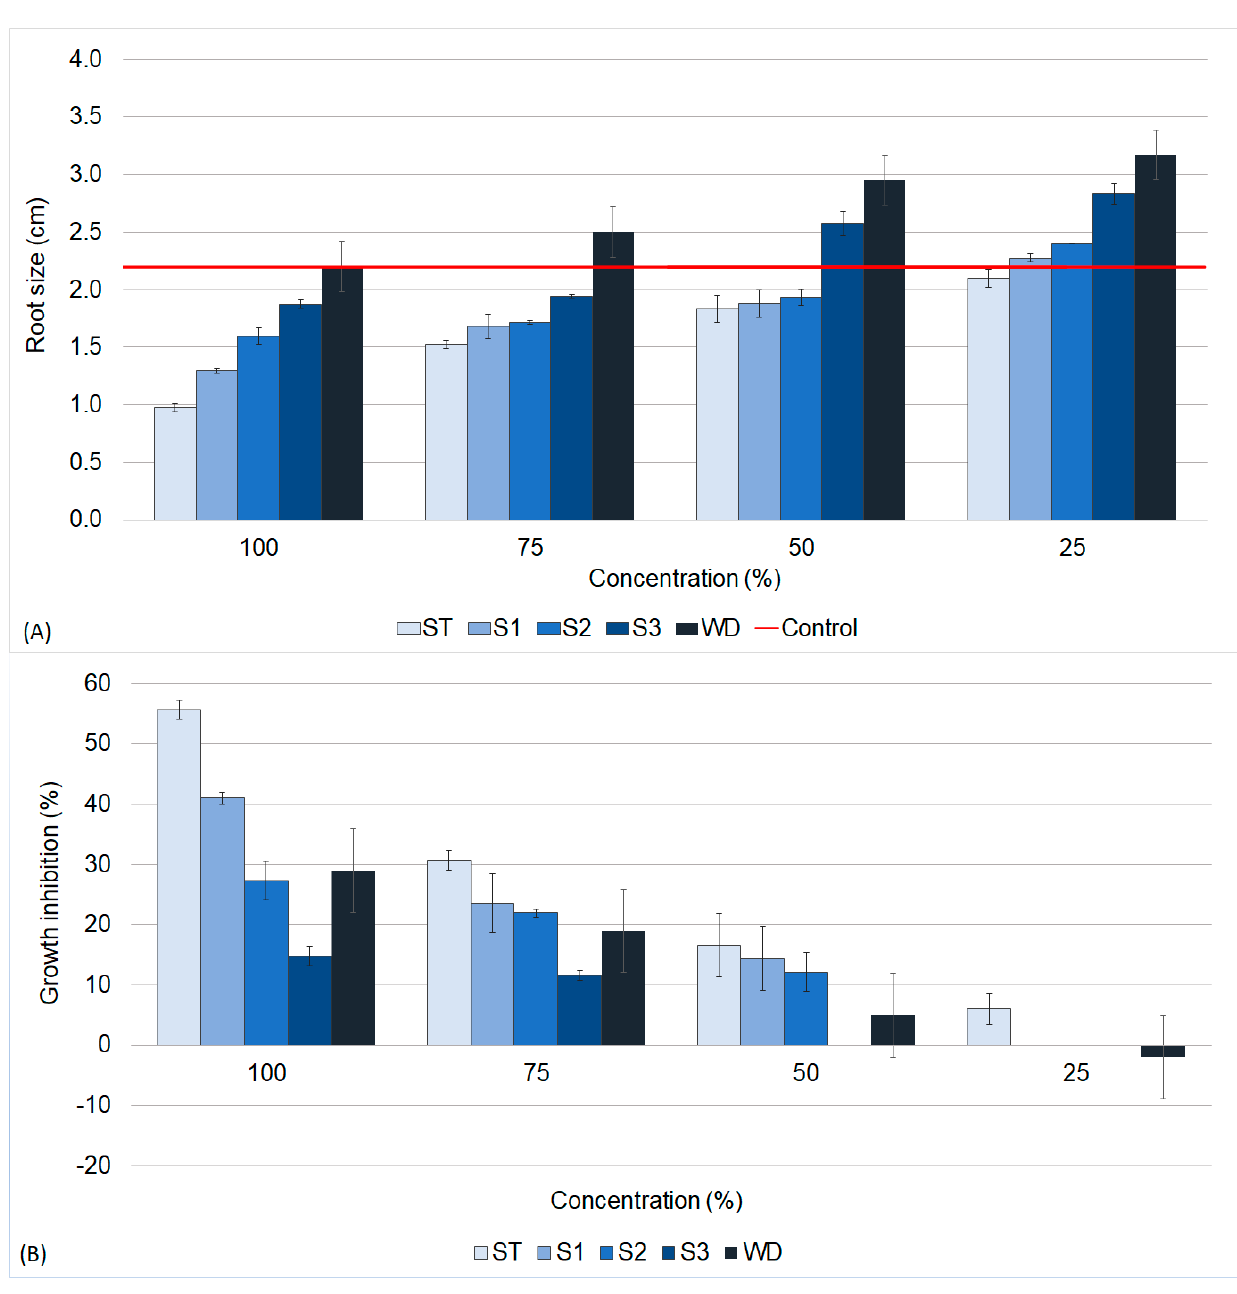
Figure 3. Root size ( A ) and growth inhibition ( B ) of Allium cepa L. bulbs exposed to different evaluated samples. Abbreviations: wastewater without diclofenac (WD); post-septic tank domestic wastewater with diclofenac (ST); post-septic tank domestic wastewater with diclofenac, treated with solar radiation for 1 h (S1), 2 h (S2), and 3 h (S3). Diclofenac concentration of 100%: 30 mg·L − 1 ; 75%: 22.5 mg·L − 1 ; 50%: 15 mg·L − 1 ; 25%: 7.5 mg·L − 1 .